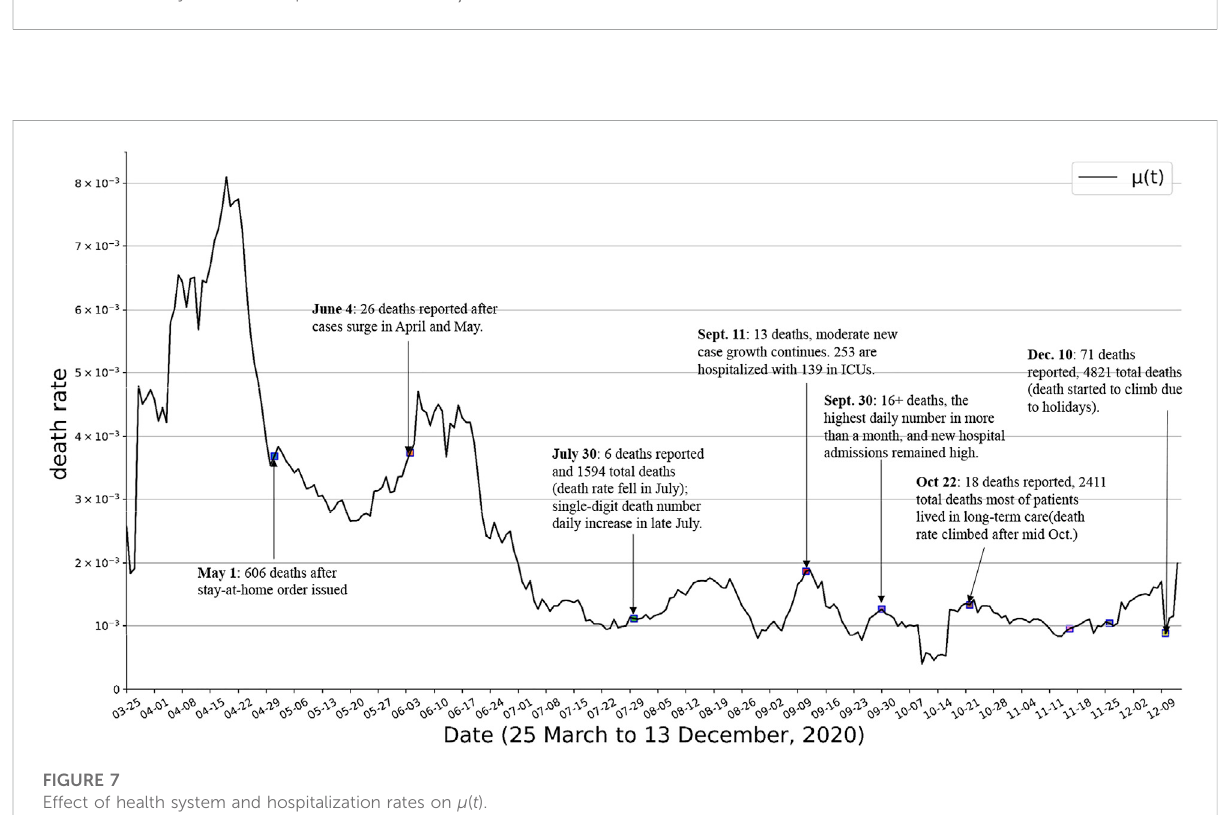
FIGURE 7 Effect of health system and hospitalization rates on μ ( t